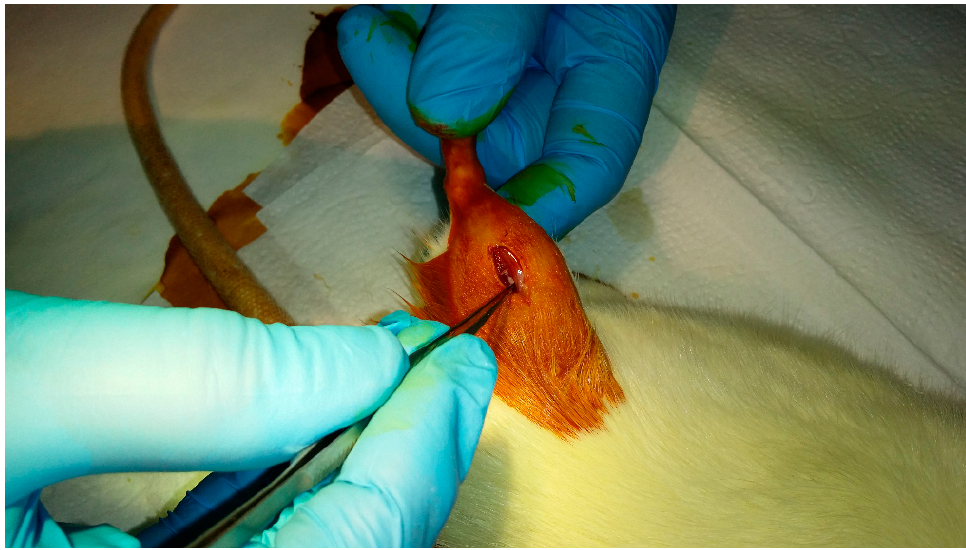
Figure 3. Implantation procedure of middle ear prosthesis into the rats’ gluteus muscle.